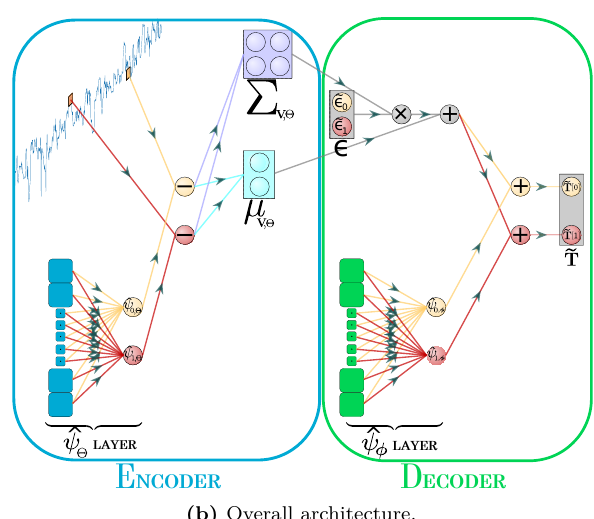
Figure 2: cVAE-SA